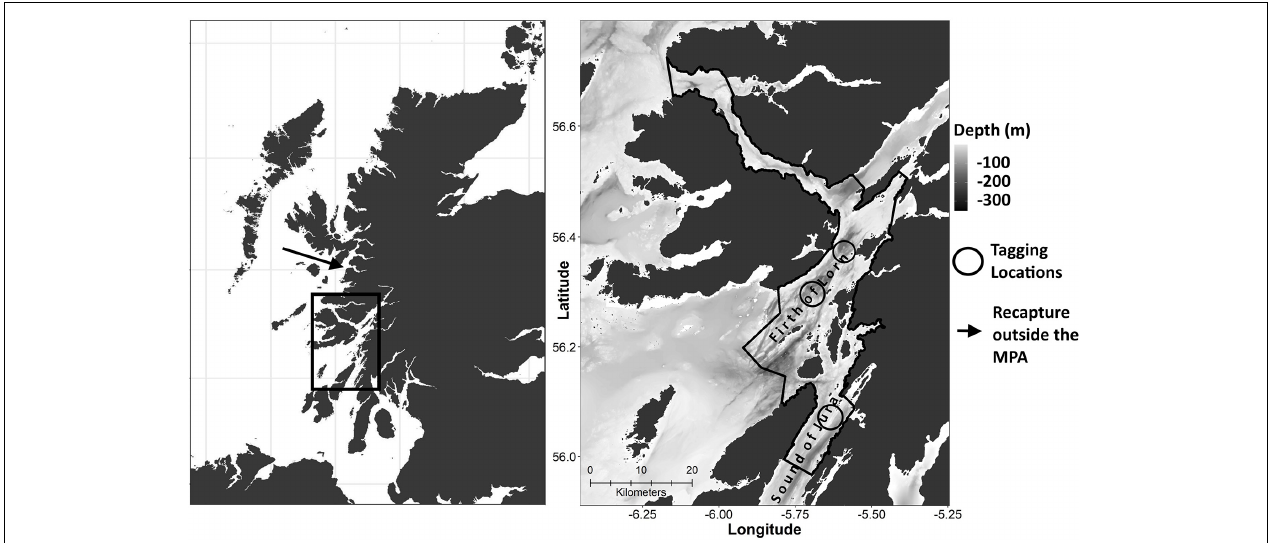
FIGURE 1 | Firth of Lorn and Sound of Jura regions on the west coast of Scotland. The left panel shows the location of the Loch Sunart to the Sound of Jura MPA in relation to Scotland and indicates the recapture location of skate ID 3 ( Table 1 ) off Mallaig. The right panel depicts the boundary of the management area, including the LStSoJ MPA and the Firth of Lorn SAC based on the management measures in the LStSoJ Marine Conservation Order 2016, the bathymetry and tag deployment sites, including the Sound of Jura site from Neat et al. (2014).